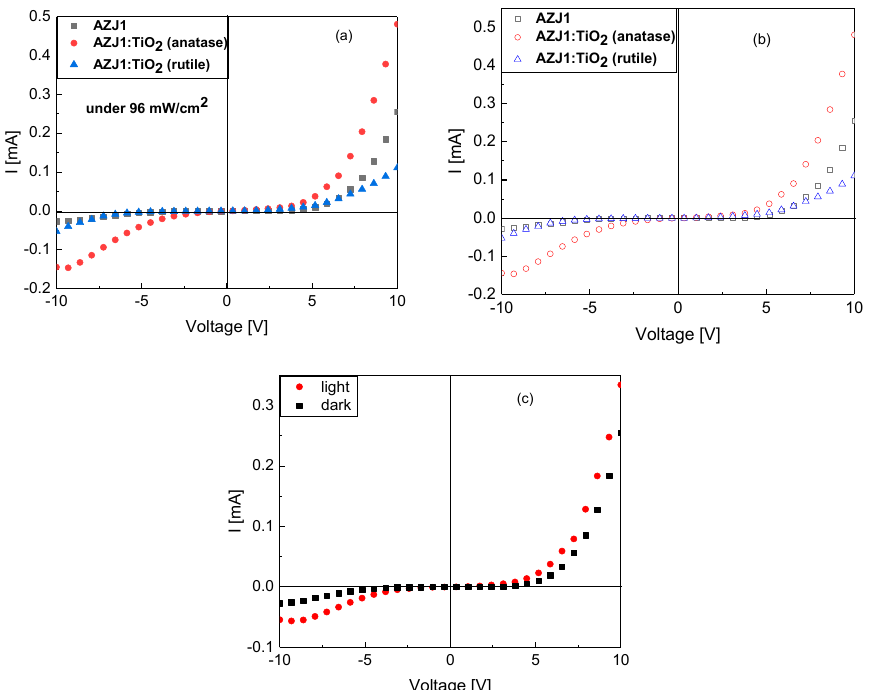
Figure 9. I–V curves of the ITO/TiO 2 /organic layer/Au under 96 mW/cm 2 illumination ( a ) and in the dark ( b ); of the ITO/TiO 2 /AZJ1/Au in the dark and under illumination ( c ).